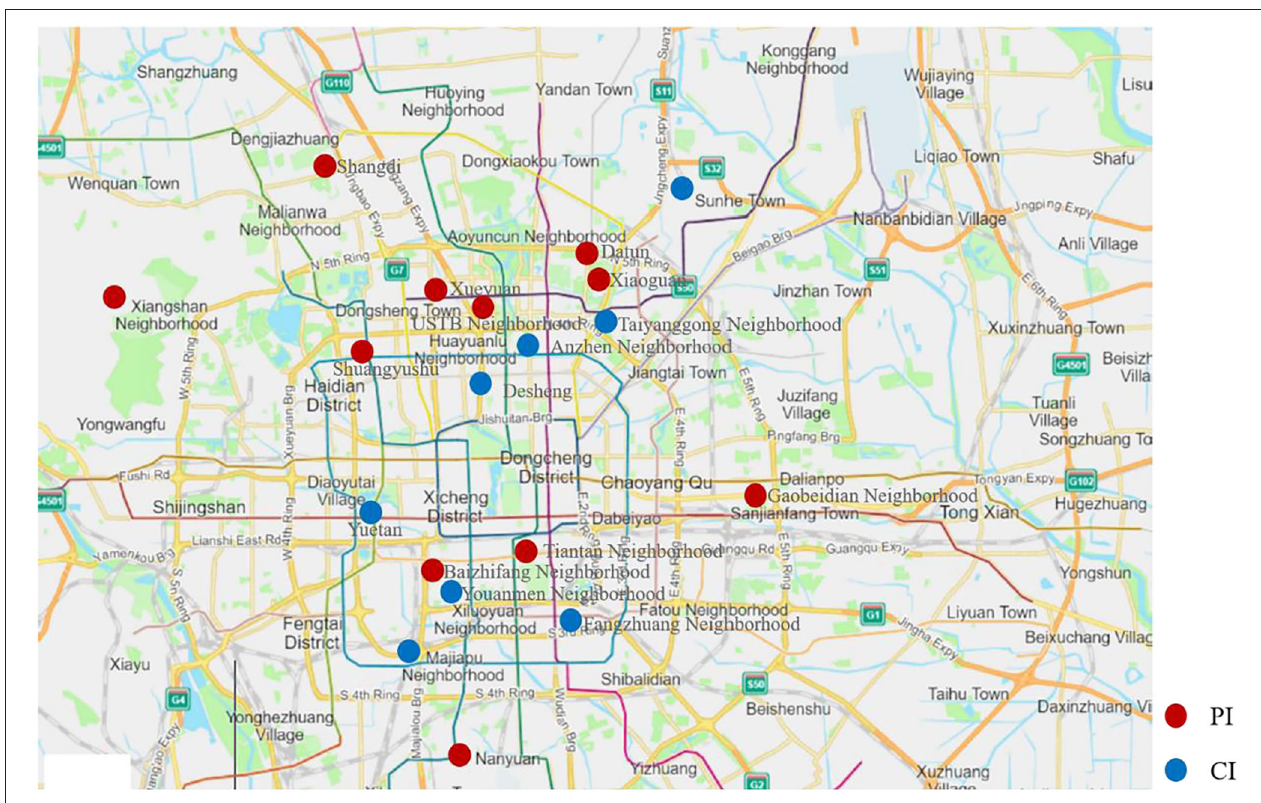
FIGURE 2 | Geographic distribution of sampling